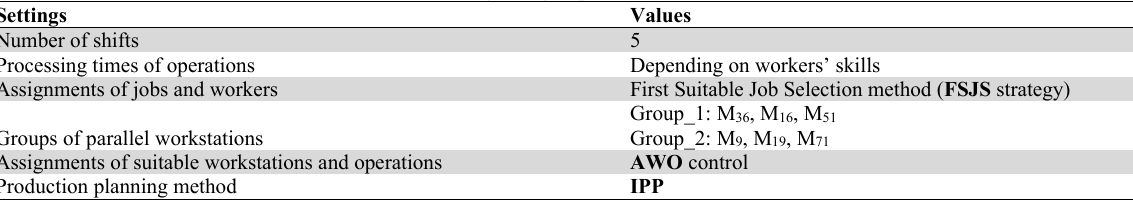
The details of the illustrative test environment for adjusting 𝛼 parameter values Settings Values Number of